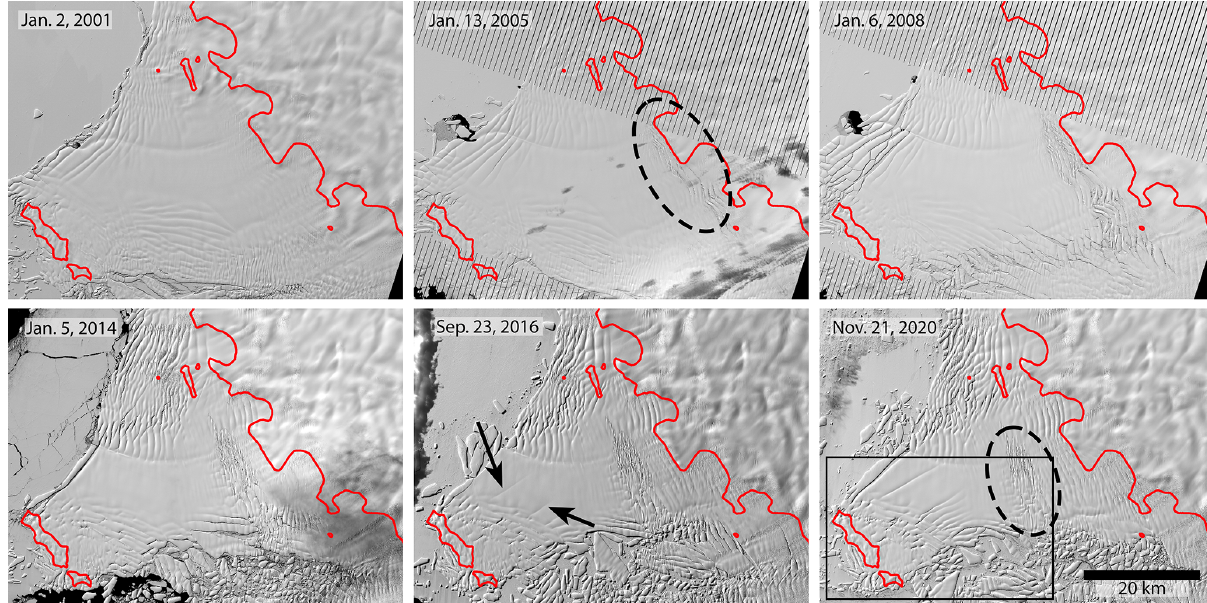
Figure 8. Landsat-7 and Landsat-8 time series of the TEIS from 2001–2020. Dashed ovals show the advection of a swarm of crevasses that opened downstream of the grounding line starting around 2005, and arrows show the formation of large rifts penetrating the centre of the TEIS starting around 2016. The rectangle in the 2020 images represents the subset area shown in Fig.